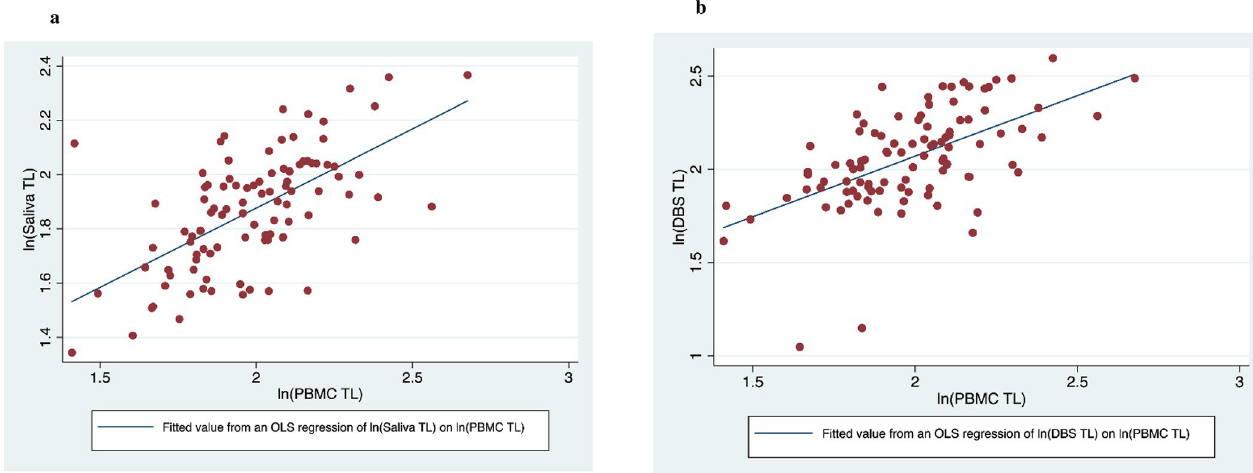
Fig 1. a. Salivary Telomere Length vs. PBMC Telomere Length. b. DBS Telomere Length v. PBMC Telomere Length.